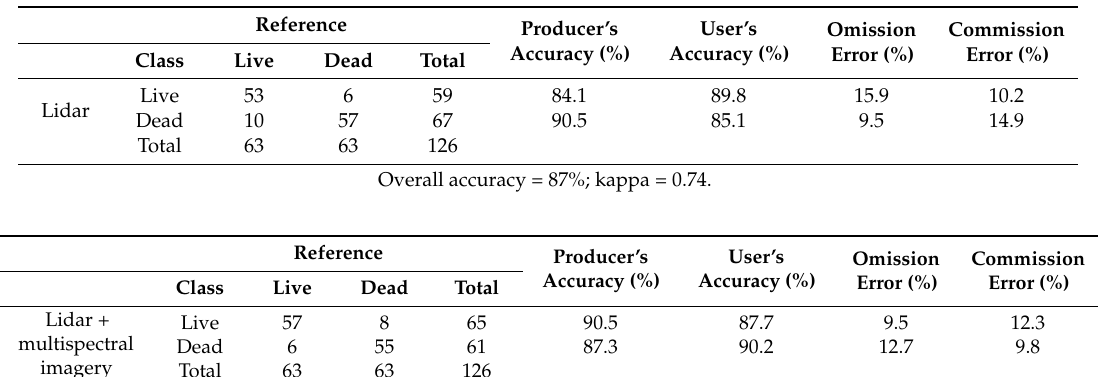
Table 3. Confusion matrices of two random forest classifications using lidar classifiers only (upper) or combined with multispectral imagery classifiers (lower).